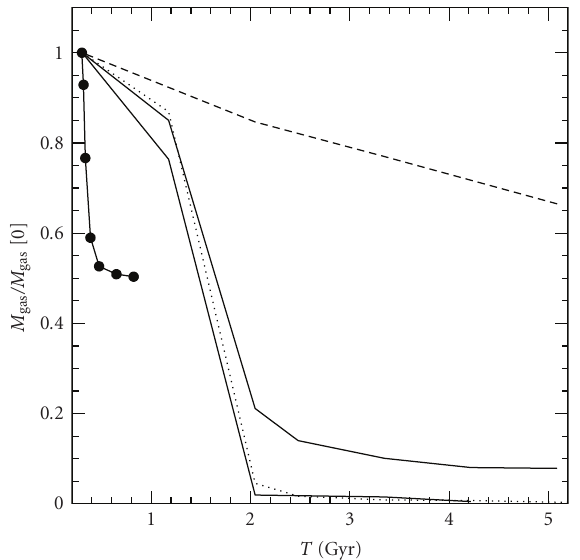
Figure 4: Time evolution of the bound gas mass for a disky dwarf galaxy model(initial V peak = 42)km/s within a Milky-Way-sized dark matter halo ( M vir (cid:2) 10 12 M (cid:2) ) having a hot gaseous halo about 1% of its total mass (see [20] for details on the modeling). The dwarf’s orbit has an apocenter of 150 kpc and a pericenter of 30kpc. The same model has been run with adiabatic gas conditions (thin solid line), radiative cooling with no heating (thick solid line), and radiative cooling plus heating by the cosmic ionizing UV background (dashed line), assuming that when the simulation is started, the time corresponds to z = 2. The long-dashed line shows the results for a run in which the hot gaseous halo of the Milky Way was absent to isolate the e ff ect of tides from that of ram pressure. Stripping from ram pressure only is instead shown by the thick solid with dots; in this run, the same dwarf model was evolved in a “wind tunnel”, moving with a speed comparable to the orbital velocity at pericenter in the other runs. In the “wind tunnel” the dwarf moves within a static gas distribution along a straight trajectory withe specified velocity (periodic boundary conditions are used for the gaseous background), but responds only to the ram-pressure force. The latter curve spans less than aGyr of evolution since ram- pressure stripping saturates quickly without tidal mass